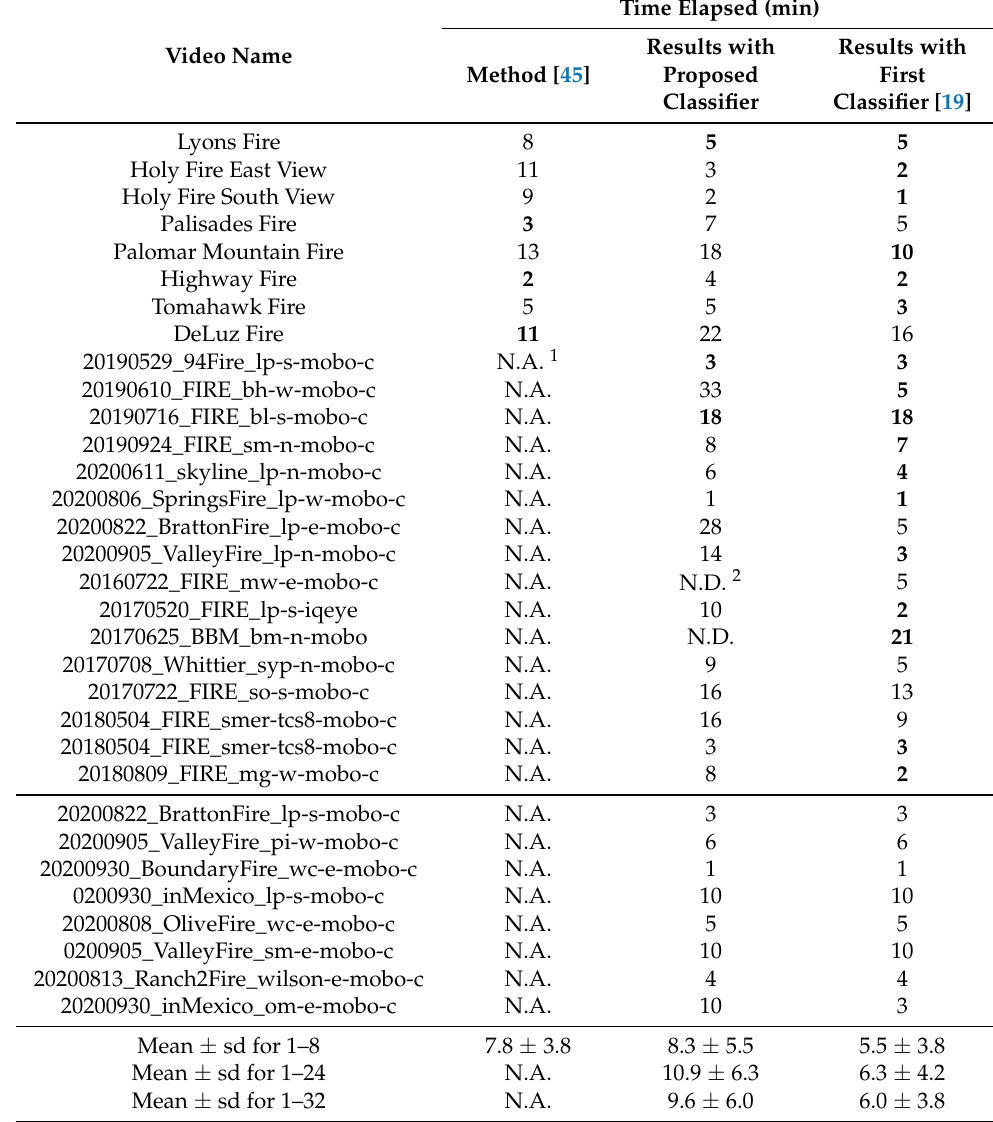
Table 5. Daytime fire detection time of smoke sequences extracted from HPWREN database. The best results for each case study are marked in